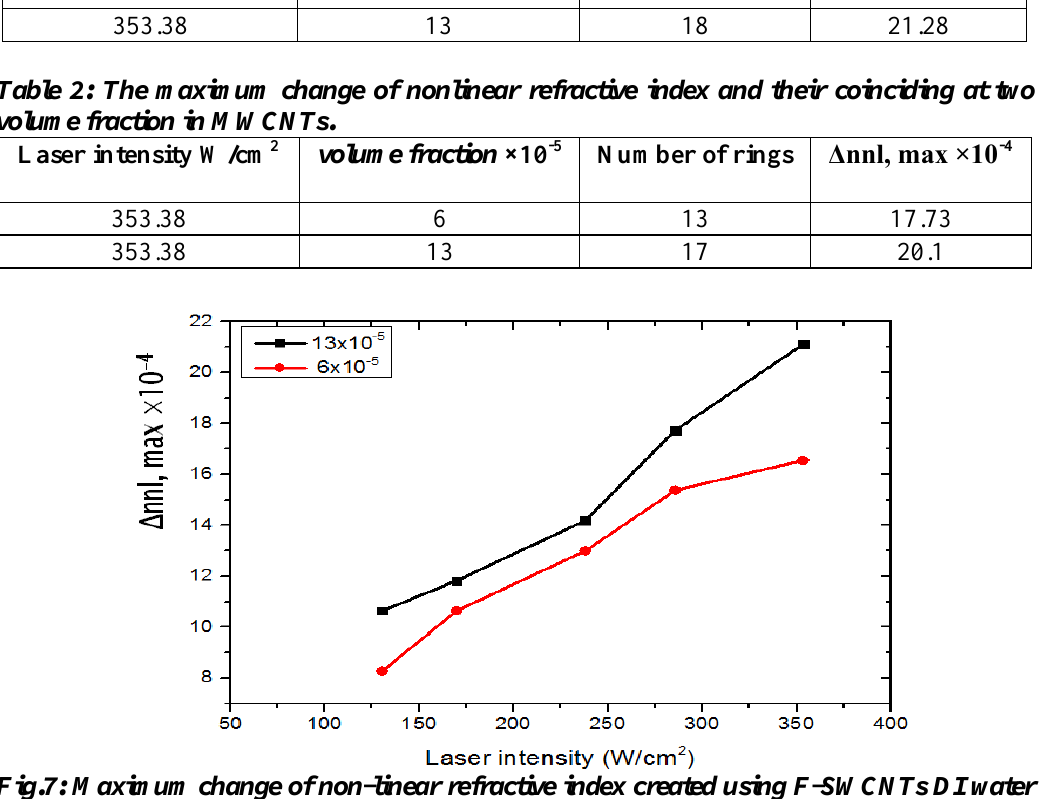
Fig.7: Maximum change of non-linear refractive index created using F-SWCNTs DI water by fraction different than (13 X10 -5 ), and (6 X10 -5 ) irradiated by laser intensity.